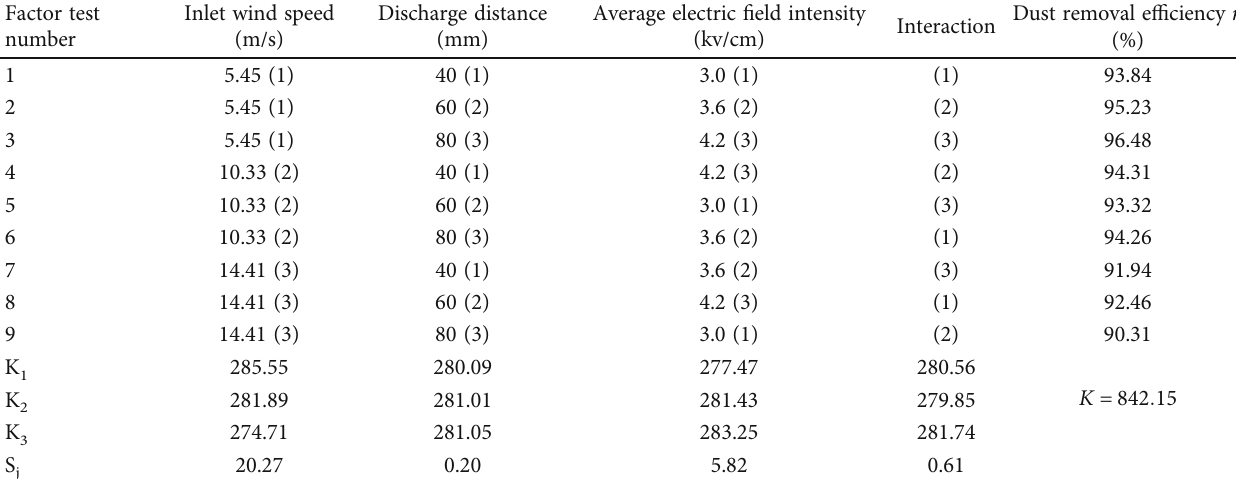
Table 1: Variance analysis of orthogonal experiment.